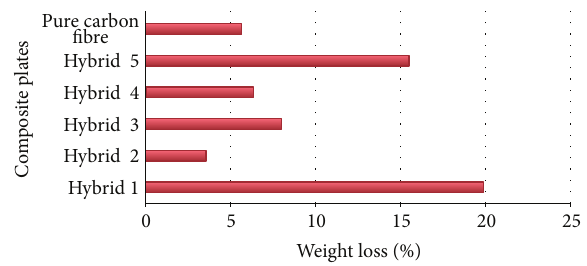
Figure 6: Comparison of the specimens’ weight losses’ percentages after ballistic impact.